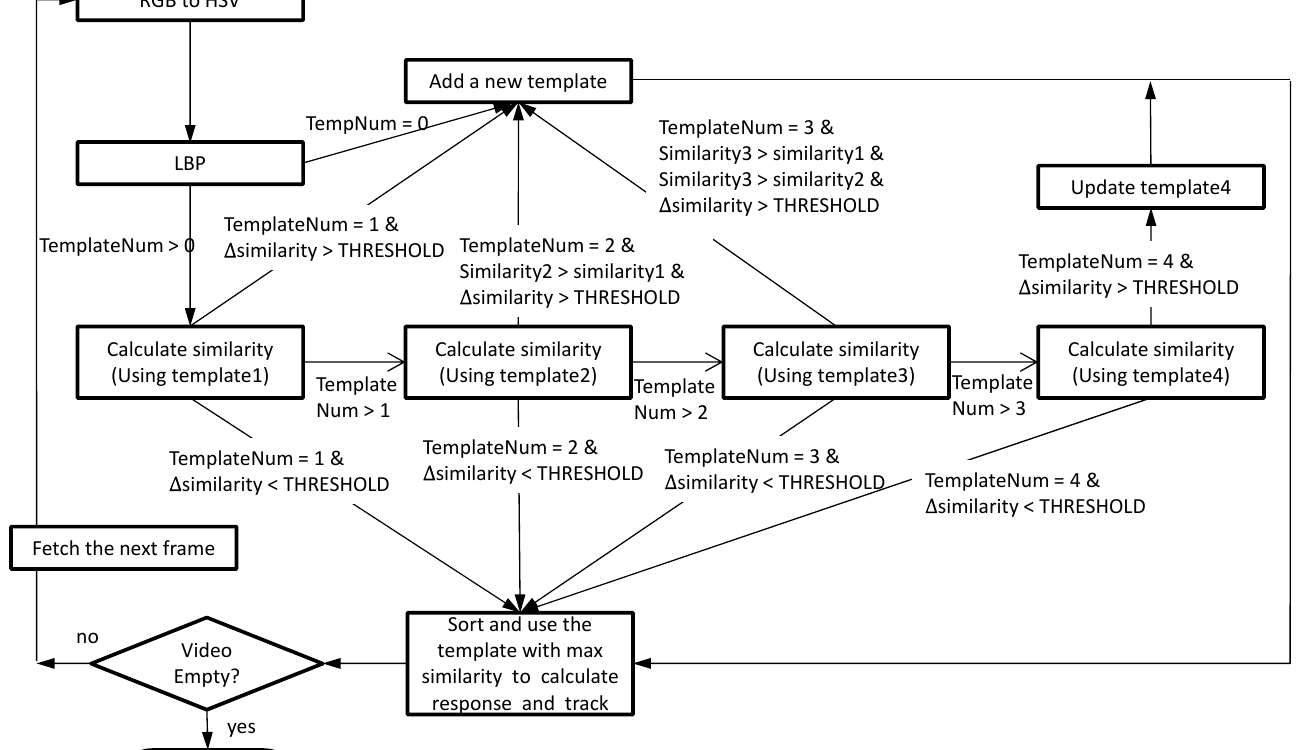
Figure 1. The operation flow of the ADMTCF.